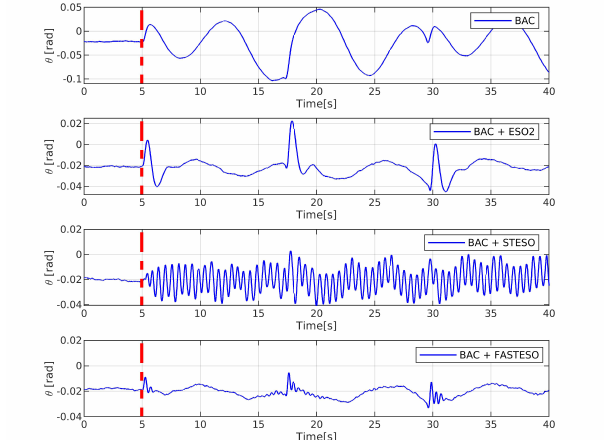
Figure 12. Results of angular rate ω x with unknown external torque disturbance under backstepping controller combined with nothing, ESO2, STESO and FASTESO.